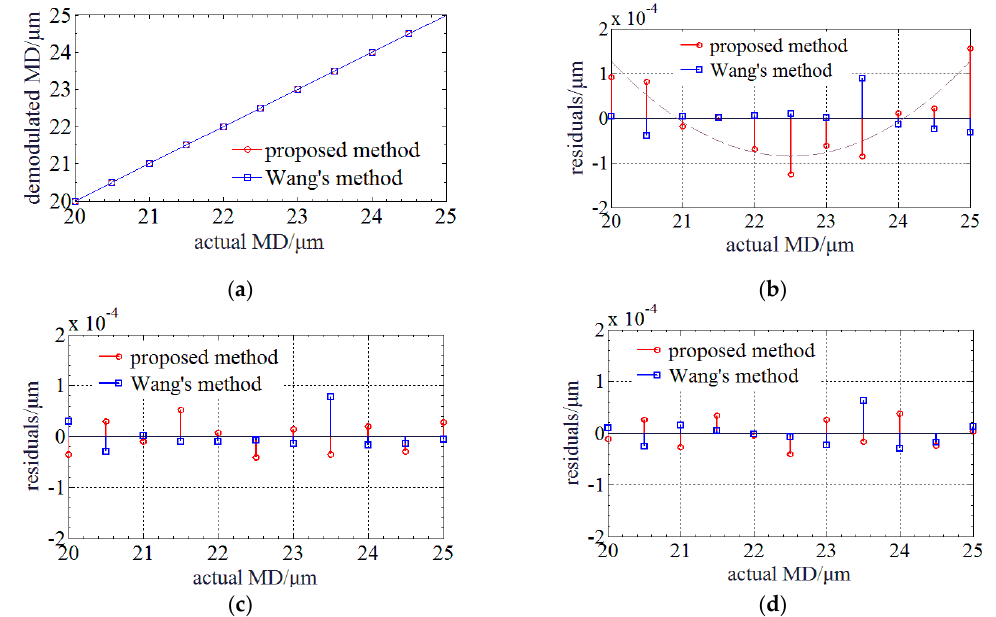
Figure 3. Relationship and fitting residuals between the demodulated and actual MD when BLS is in Gauss profile: ( a ) Relationship between the demodulated and actual MD; ( b ) Linear polynomial fitting residuals; ( c ) Quadratic polynomial fitting residuals; ( d ) Cubic polynomial fitting residuals.